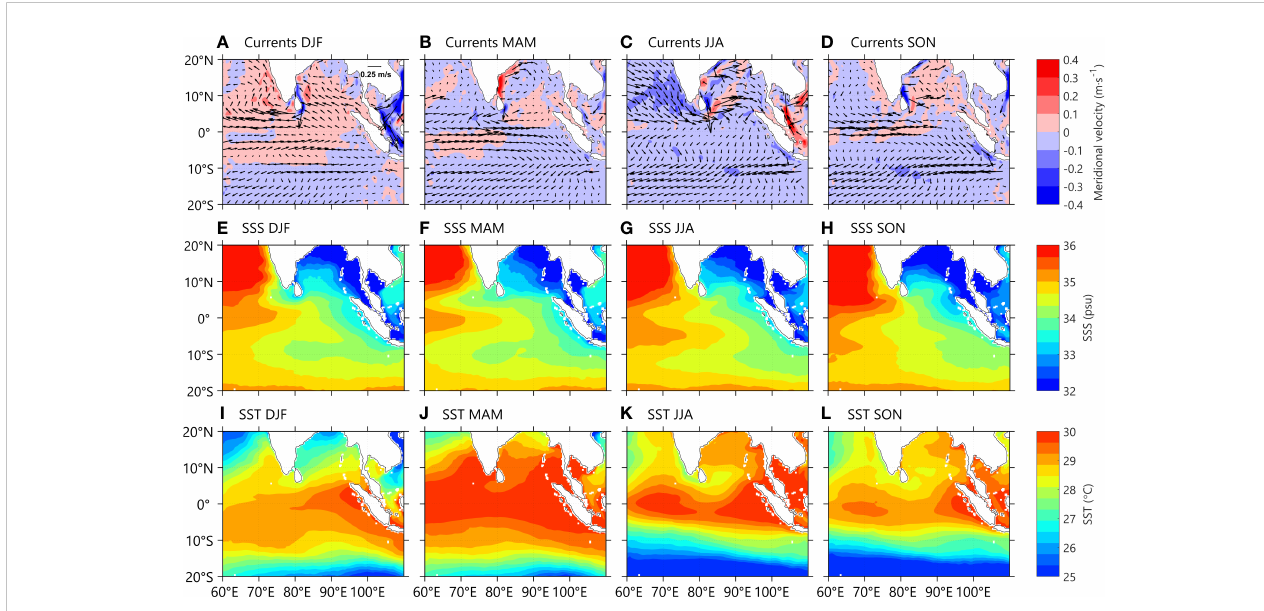
FIGURE 2 Same as Figure 1, but obtained from the ECCO2 data.